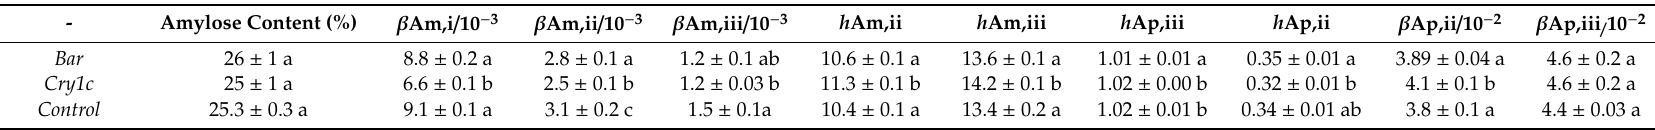
Table 3. Fitted molecular structural parameters of starch in the retrograded maize starch samples, made from duplicate measurements. Di ff erent letters within a row indicate significant di ff erences ( p <